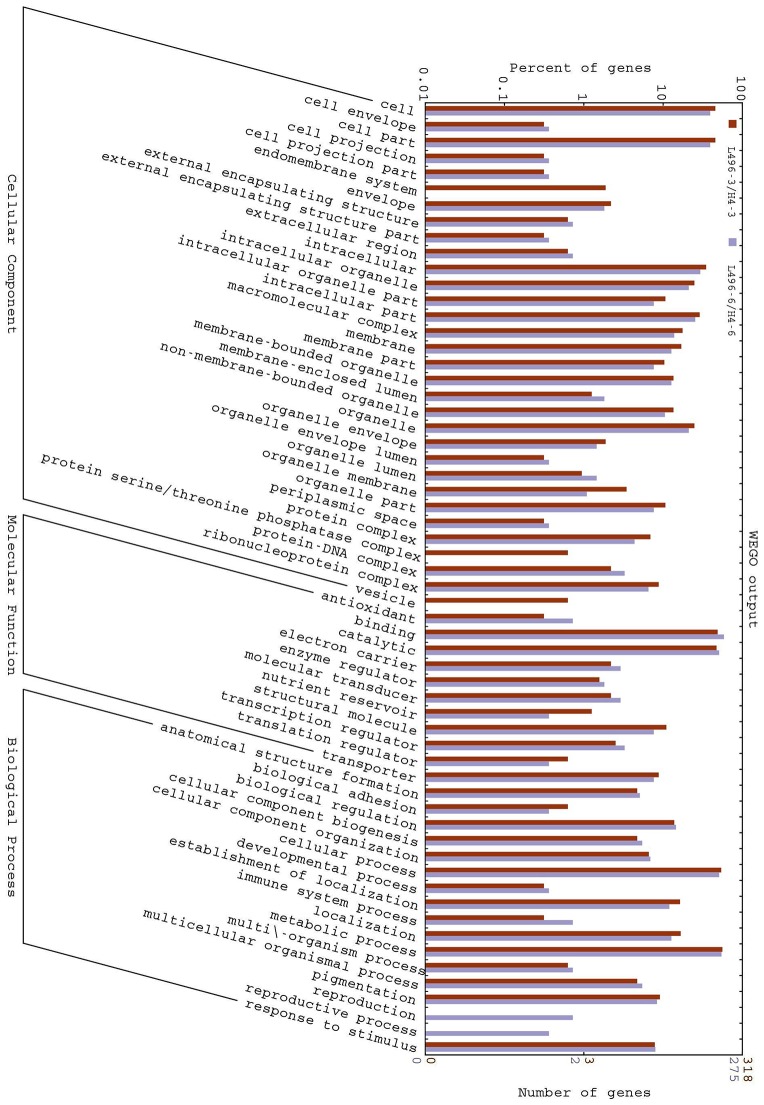
Gene Ontology (GO) classification of differentially expressed proteins at the three- and six-leaf stages identified by iTRAQ-labeling experiments between HZ4 and H496. The differentially expressed proteins are grouped into three hierarchically structured GO terms: biological process, cellular component, and molecular function. The y-axis indicates the number and percent of proteins in each GO term.